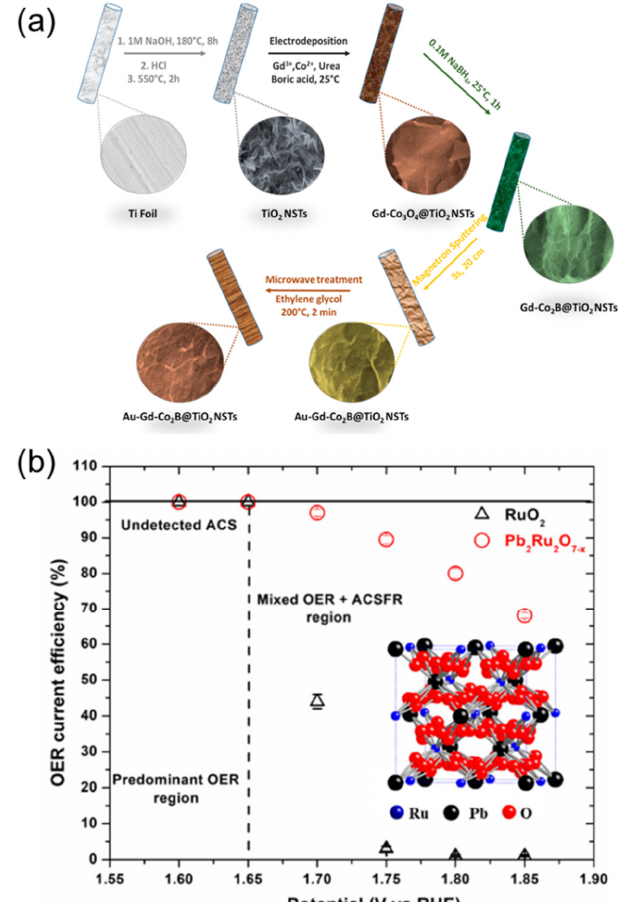
Figure 5. ( a ) Systematic illustration of the fabrication of Au-Gd-Co 2 B@TiO 2 [33]; ( b ) the OER activity of Pb 2 Ru 2 O 7 − x in alkaline simulated seawater [35].